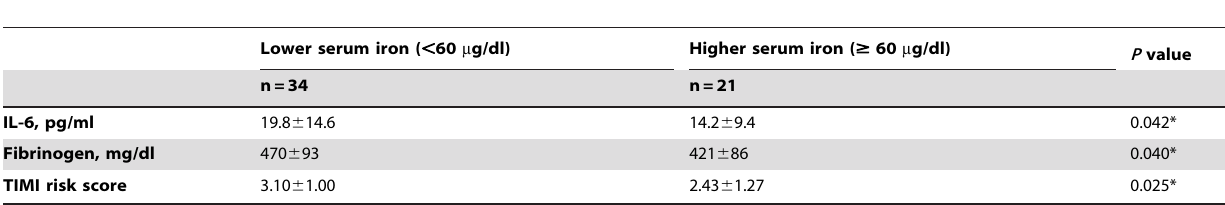
Table 4. Lower serum iron concentration is associated with higher inflammatory markers and TIMI risk score after acute myocardial